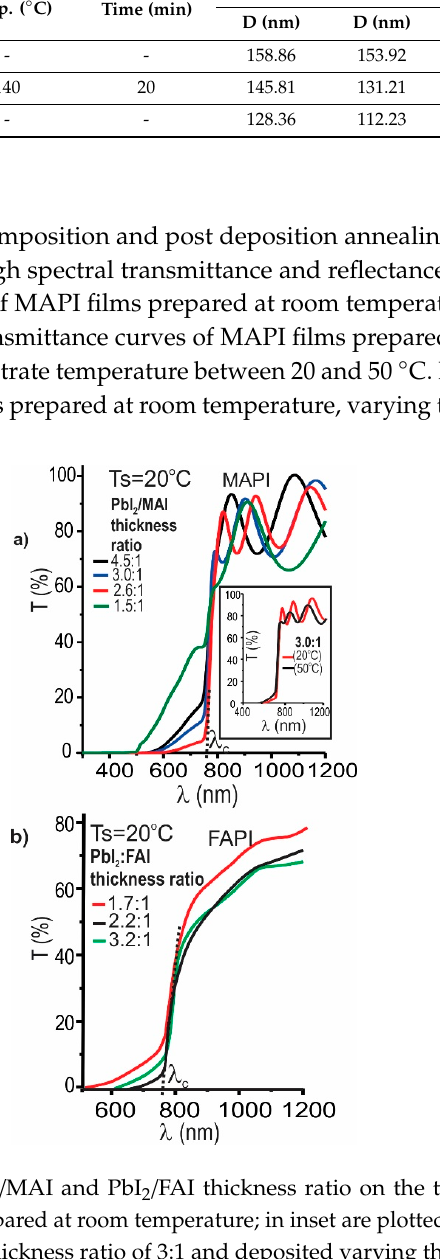
Table 2. Influence of the PbI 2 / MAI (and PbI 2 / FAI) thickness ratio and post deposition annealing temperature on the crystallite size D, grain size, and micro-strain